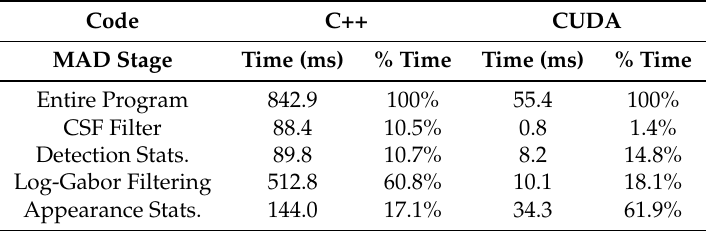
Table 3. Results of the follow-up experiment on the secondary test system (IVC database; Tesla